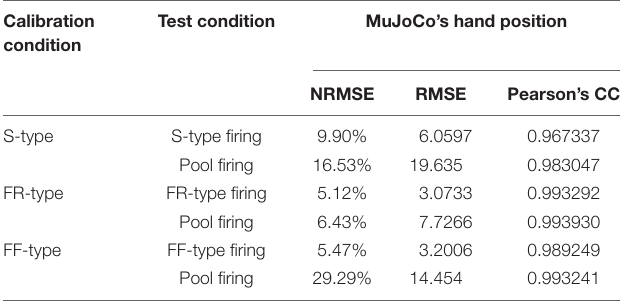
TABLE 1 | Cell-type neural decoders’ performance